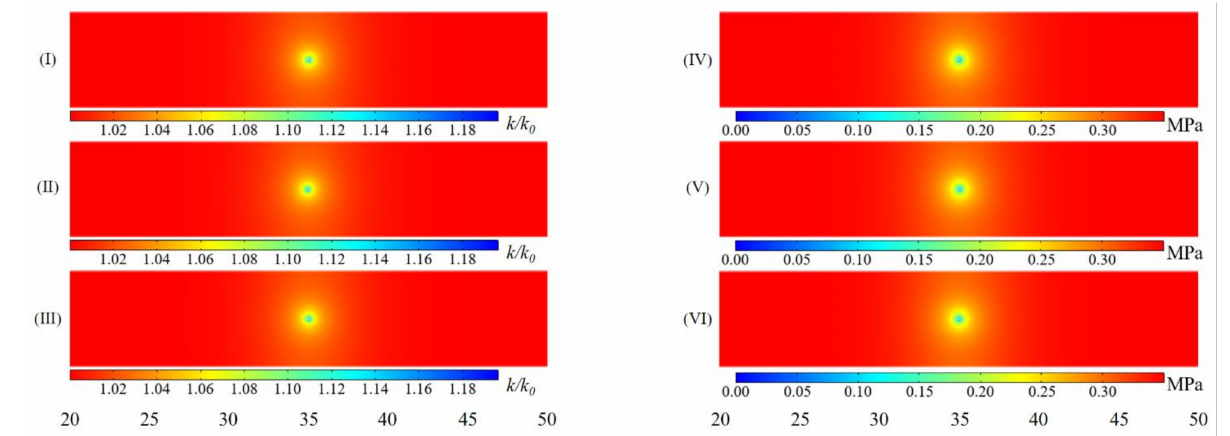
Figure 8. Cloud chart of permeability and gas pressure distribution of different mesh types at 10 d of drainage: ( I – III ) are the permeability distribution of mesh type from normal to finer; ( IV – VI ) are the gas pressure distribution of mesh type from normal to finer.